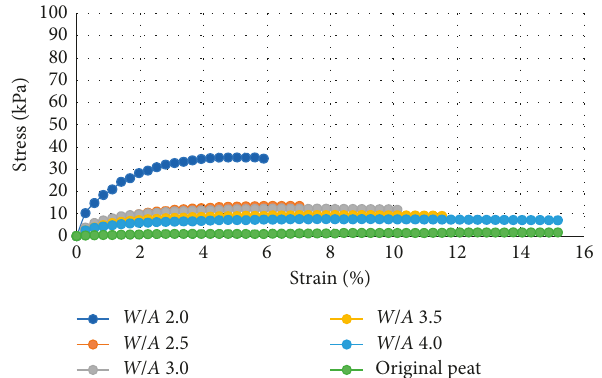
Figure 7: UCS value vs. curing time for peat A specimens ( w 1210%). (cid:31)